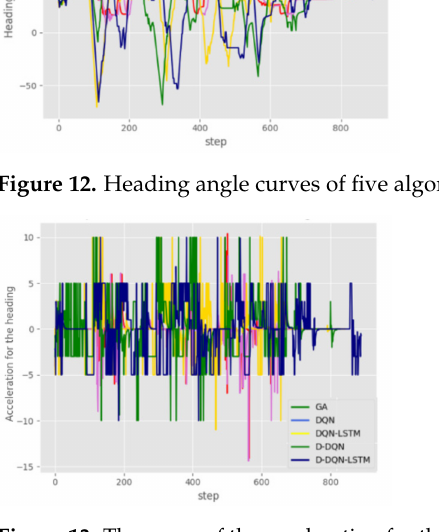
Figure 13. The curve of the acceleration for the heading of the five algorithms in a static